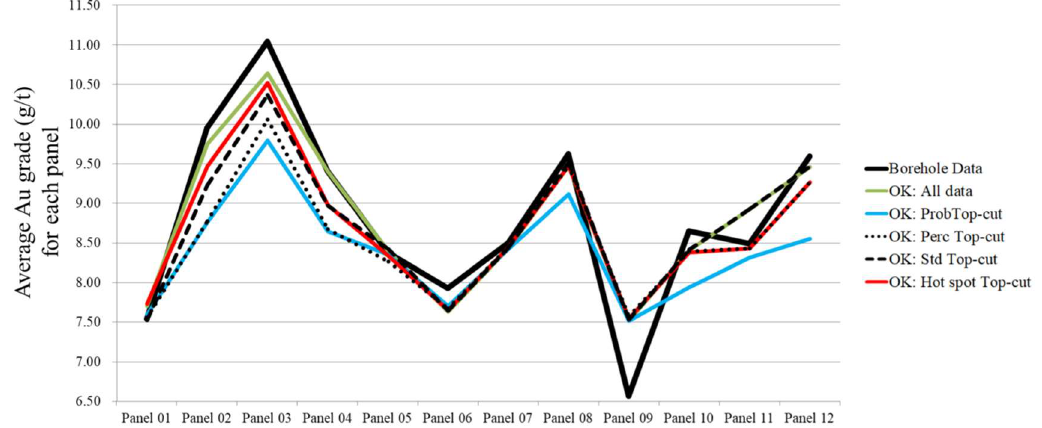
Figure 10. Validation of the Au grade estimation for each panel using the line-diagram. Table 2. The average of kriging predictions and borehole data for each panel.